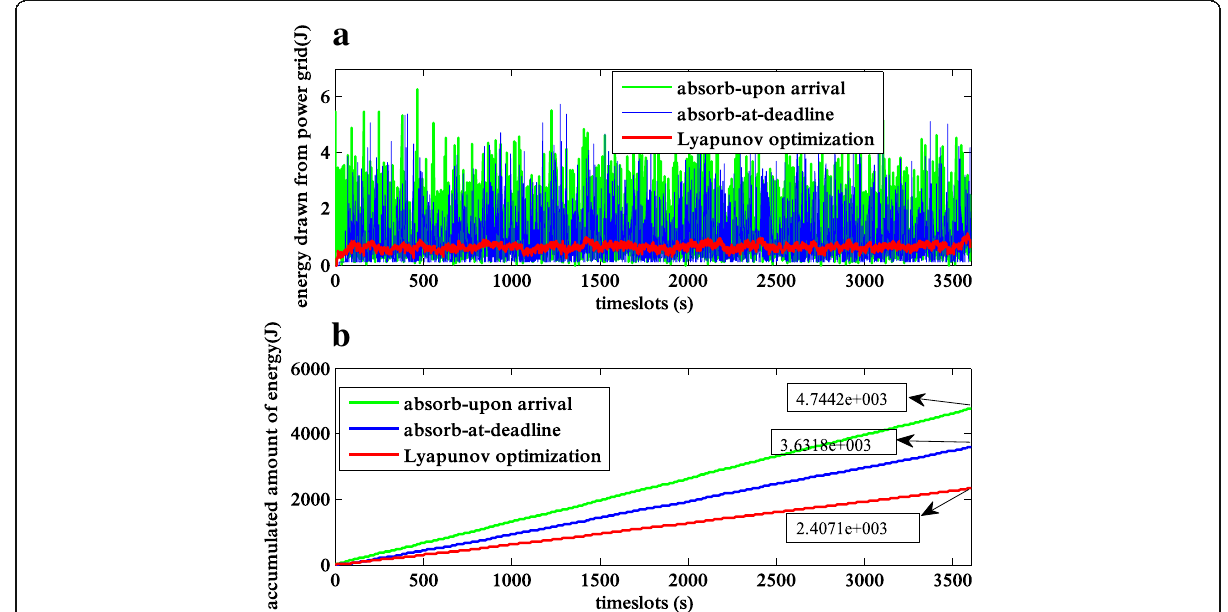
Fig. 4 Performance comparison of three strategies. a Energy consumption from the power grid in every timeslots. b Accumulated amount of energy consumption from power grid over a